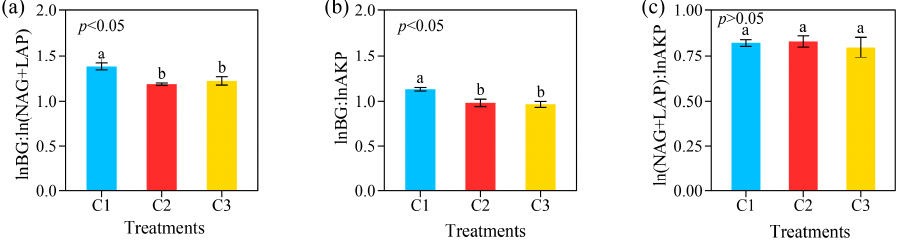
Figure 2. The ecoenzymatic stoichiometry in compound soils with different feldspathic sandstone- to-sand ratios. ( a ) Enzyme C:N rations, ( b ) enzyme C:P ratios, ( c ) enzyme N:P ratios. BG: β -1,4- glucosidase, NAG: β -N-acetylglucosaminidase, LAP: Leucine aminopeptidase, AKP: alkaline phos- phatase. Different lowercase letters represent significant differences at the 0.05 level. C1, C2, and C3 represent ratios of feldspathic sandstone to sand of 1:5, 1:2, and 1:1. Error bars are the standard errors ( n = 3).